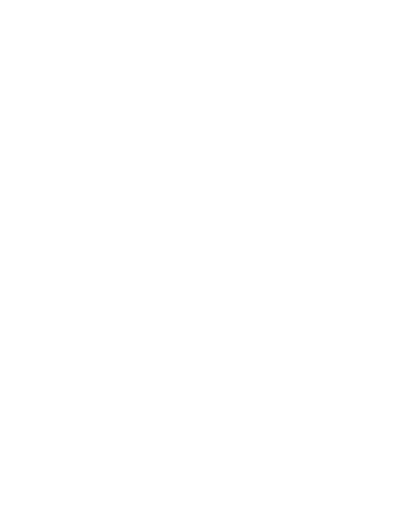
Table 1. Cohort demographics. 1 Median (IQR); n